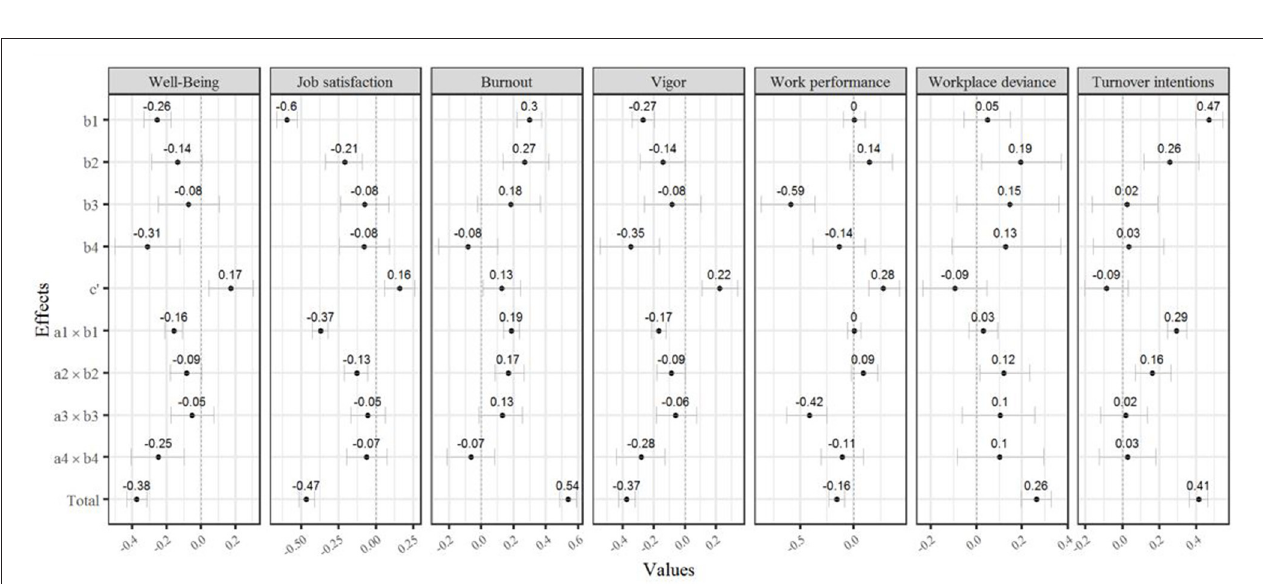
FIGURE 3 | Psychological contract violation and basic need frustrations as mediators between workspace bullying and outcomes: Parameters. For paths related to “a” see Figure 2 . CI 95 based on 10,000 bootstrap approach; R 2 well − being = 0.33; R 2 job satisfaction = 0.59; R 2 burnout = 0.447; R 2 vigor = 0.36; R 2 work performance = 0.19; R 2 workplace deviance = 0.17; R 2 turnover intentions =